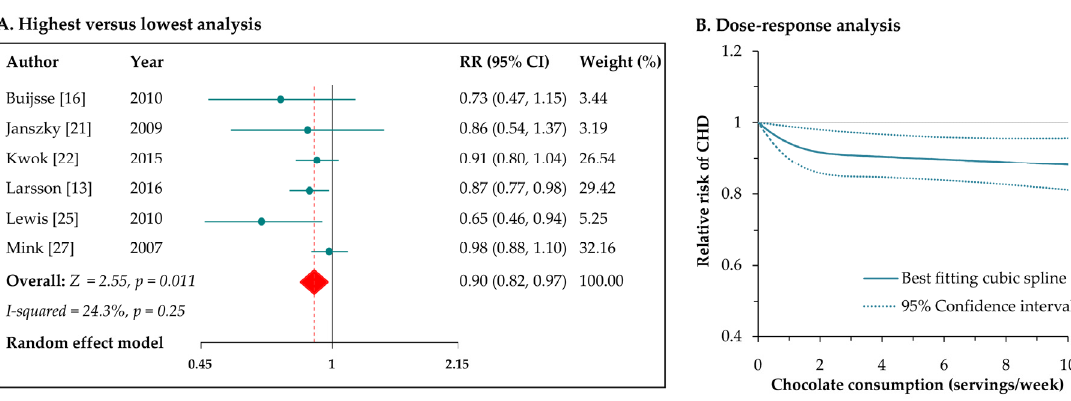
Figure 2. Meta-analyses of chocolate consumption and risk of coronary heart disease (CHD). CI: confidence interval; RR: relative risk.